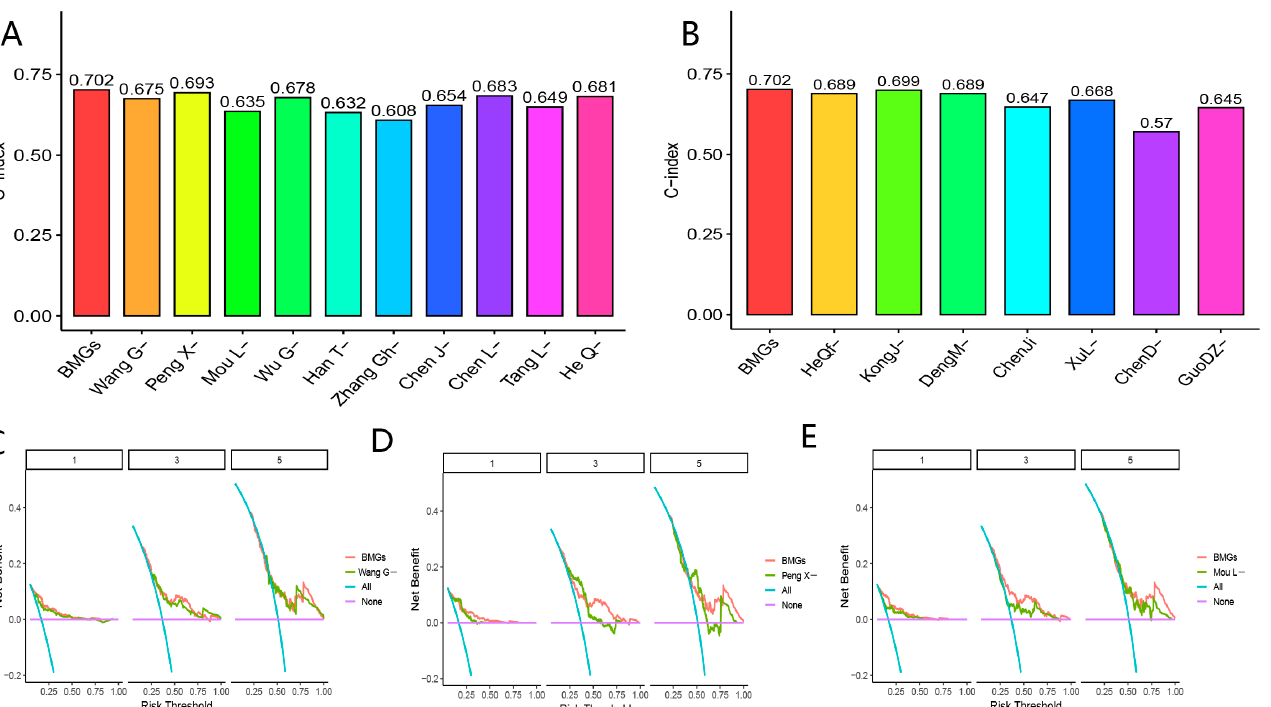
Figure 10. Comparison with other gene signatures. ( A ) C-index analyses about BMGs and 10 gene signatures in PubMed databases for prediction of the prognoses of HCC. ( B ) C-index analyses about BMGs and seven gene signatures in PubMed databases for prediction of the prognoses of HCC. ( C ) Decision curve analyses of BMGs and the Wang G-study. ( D ) Decision curve analyses of BMGs and the Peng X-study. ( E ) Decision curve analyses of BMGs and the Mou L-study. ( F ) Decision curve analyses of BMGs and the Han T-study. ( G ) Decision curve analyses of BMGs and the Chen Ji-study. ( H ) Decision curve analyses of BMGs and the Tang L-study. ( I ) Decision curve analyses of BMGs and the He Qf-study. ( J ) Decision curve analyses of BMGs and the He Q-study. ( K ) Decision curve analyses of BMGs and the Kong J-study. 3.3.4. Construction of BMGs-Based Nomogram To comprehensively apply BMGs to clinical practice, the nomogram based on BMGs, gender, TNM-stage, and age was created in the TCGA-LIHC cohort (Figure 11A). The